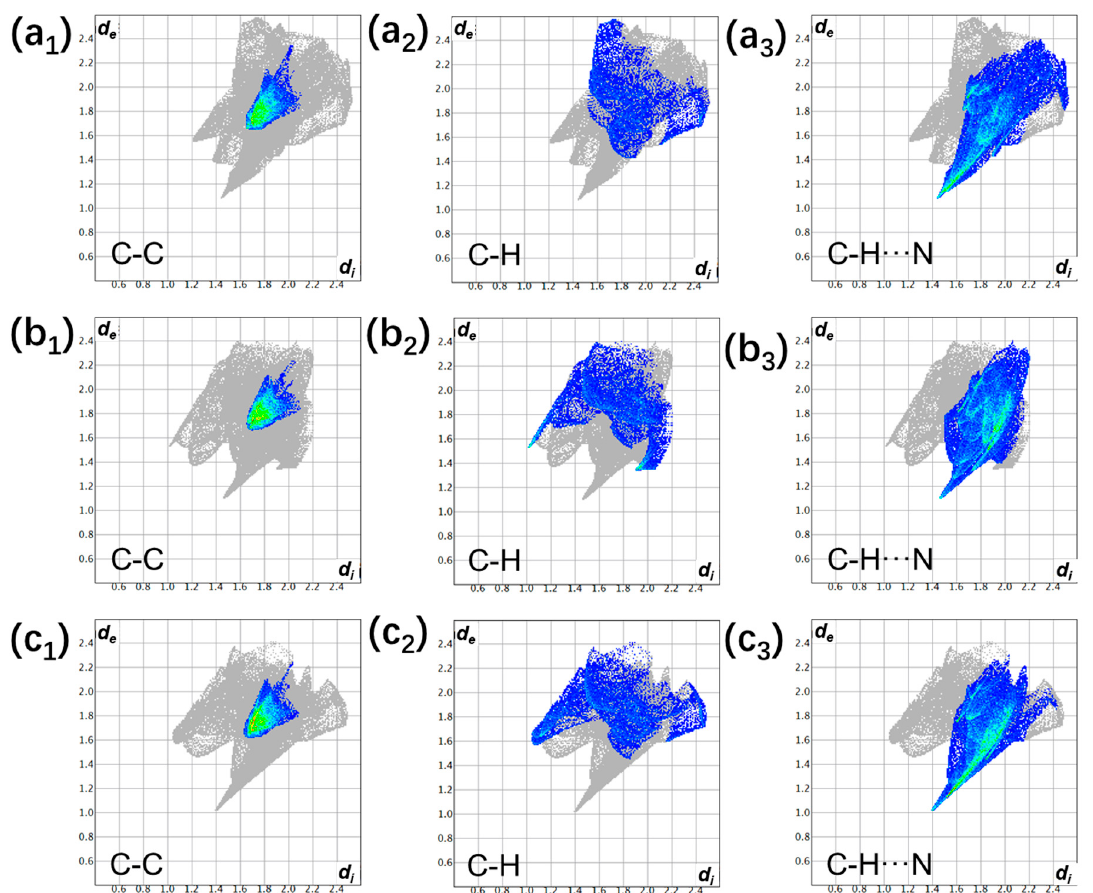
Figure 10. Fingerprint plots visualizing d e and d i for C···C, C···H, C–H···N contacts (including reciprocal ones) generated for TCNQ in P1T1 ( a 1 , a 2 , a 3 ), P2T1 ( b 1 , b 2 , b 3 ), and P3T1 ( c 1 , c 2 , c 3 ).